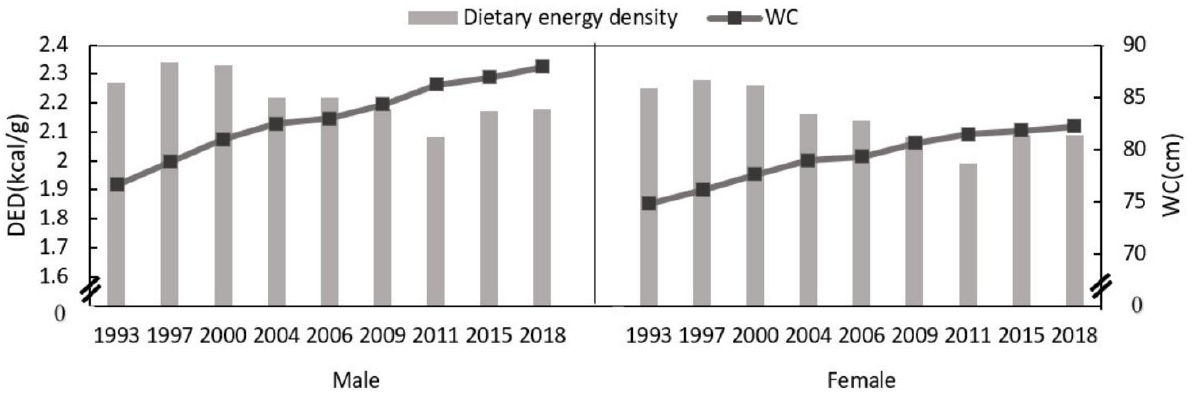
Figure 1. Changes in DED and waist circumference of male and female aged 18 – 64 years from 1993 to 2018.